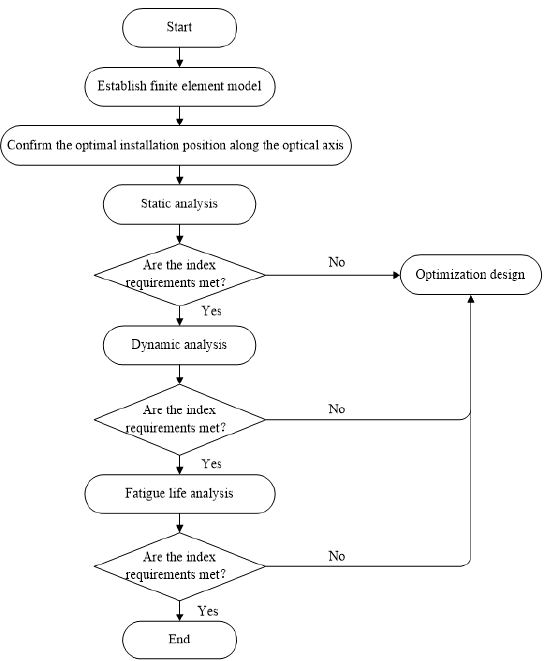
Figure 5. Analysis flow diagram.